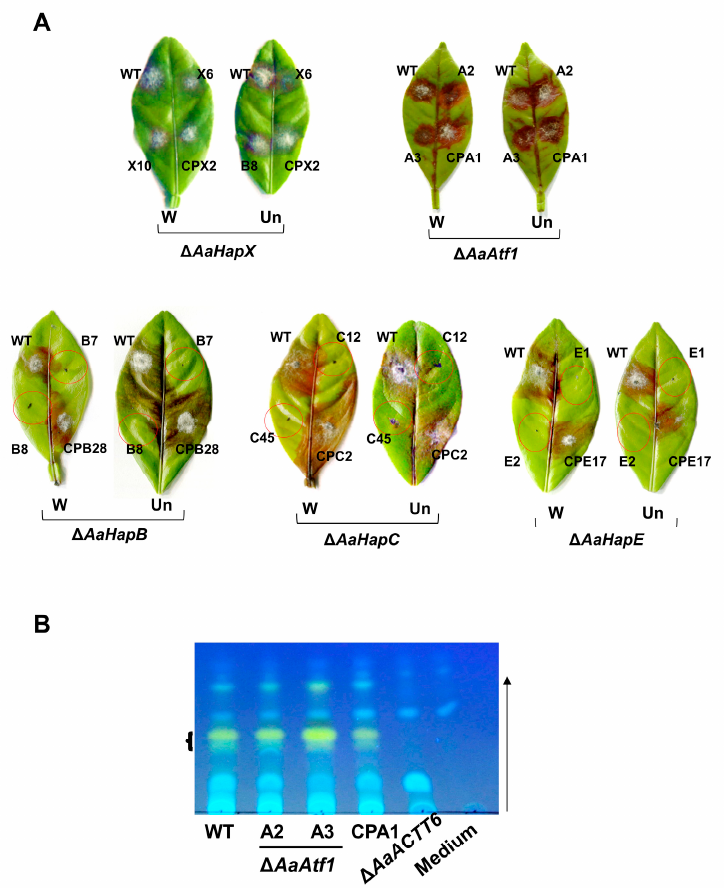
Figure 7. AaHapX and AaAtf1 play no role in A. alternata pathogenesis. ( A ) Pathogenicity tests assayed on detached calamondin leaves revealed that ∆ AaHapX (X6 and X10) and ∆ AaAtf1 (A2 and A3) induced necrotic lesions at rates and magnitudes similar to the wild type and their respective complementation (CP) strains in pre-wounded (W) or un-wounded (Un) leaves. In contrast, ∆ AaHapB (B7 and B8), ∆ AaHapC (C12 and C45), and ∆ AaHapE (E1 and E2) barely induced necrotic lesions. ( B ) TLC analysis of toxin purified from wild type, ∆ AaAtf1 (A2 and A3), and the complementation strain (CPA1) revealed that deleting AaAtf1 had no effects on ACT production. No ACT was detected from medium only or culture filtrates of ∆ AaACTT6 (an ACT deficient strain). The arrow indicates the direction of the mobile phase